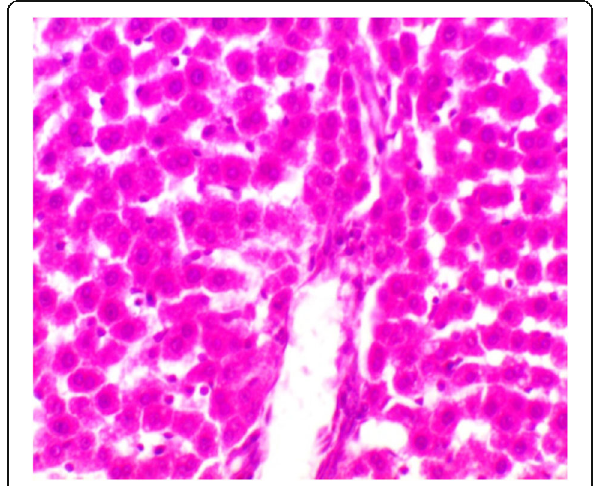
Fig. 10 Photomicrograph of liver section after CCL4 + NAC treatment showing improvement in liver architecture (H&E) ×400